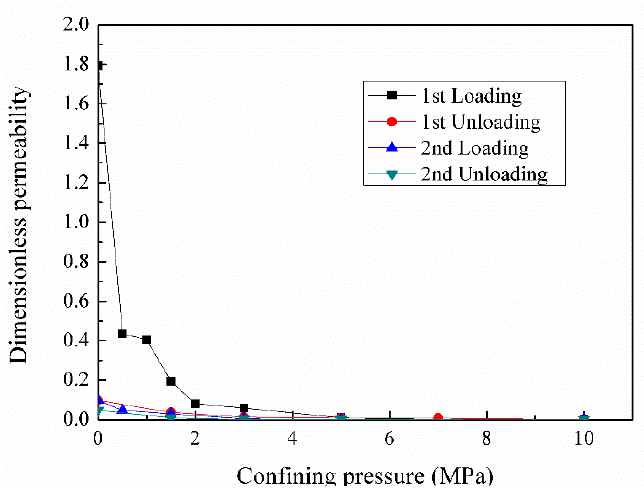
Figure 14. The relationship between permeability and confining pressure of the second cycle.